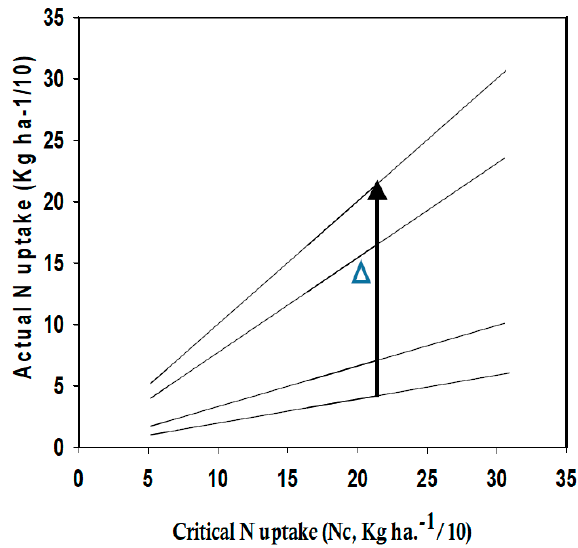
Figure 6. Correlation between limited applications of N (0, 6, 12 N units) and 18 critical N (Nc). The slope (uptake of actual N vs. uptake of Nc) is the Nitrogen Nutritional Index (NNI) for each N level.